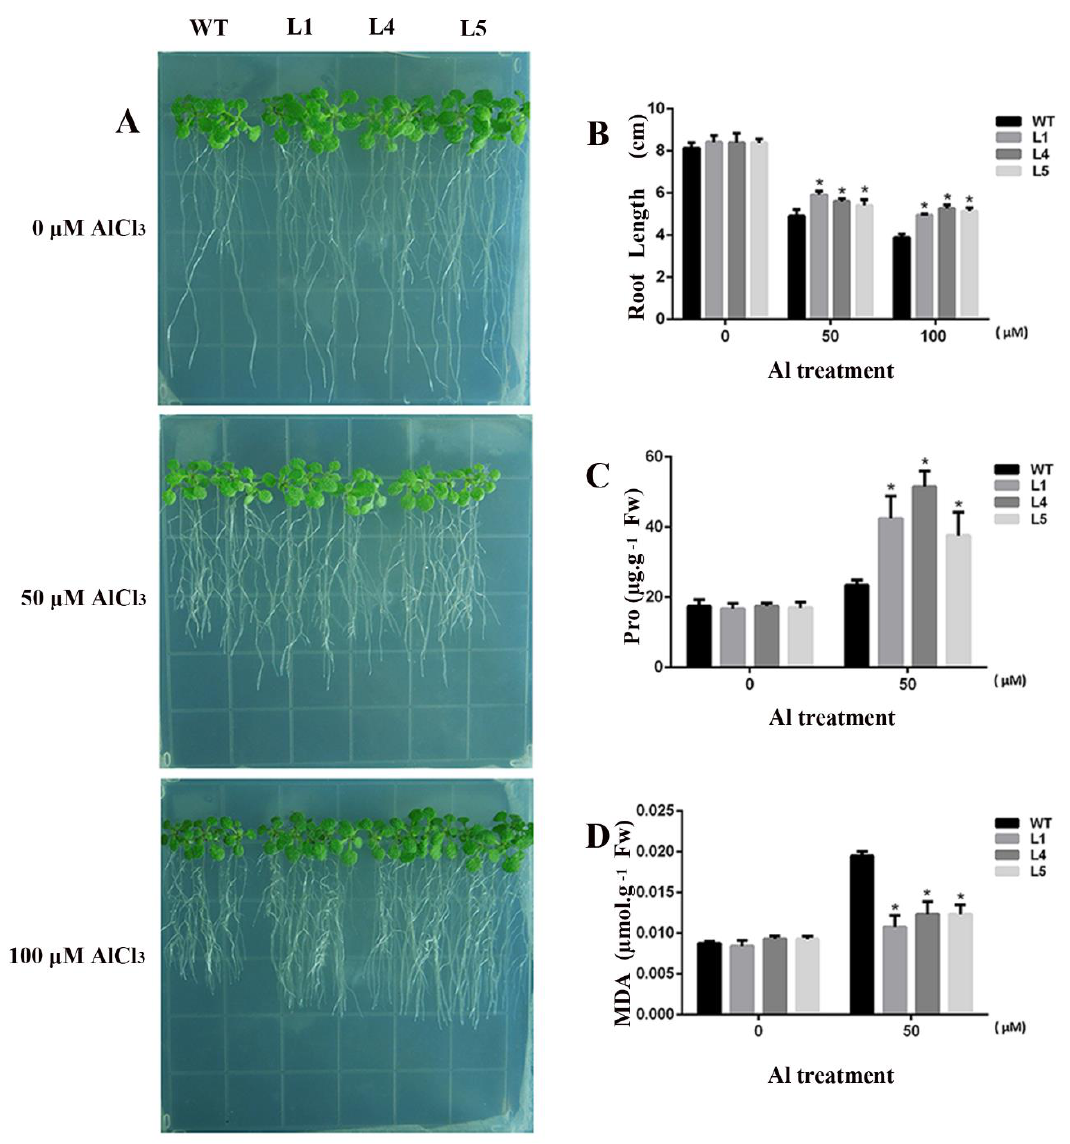
Figure 4. Overexpression of GsGIS3 in Arabidopsis enhanced Al tolerance. ( A ) The phenotypes of transgenic lines and control under AlCl 3 treatment for seven days. ( B ) Statistical analysis of root elongation. ( C ) The determination of proline content. ( D ) The determination of MDA content. The vertical columns for the average observation value of the three repetitions represent the means ± SD. Three independent biological experiments were carried out to investigate the status of seedlings and accumulations of proline and MDA in plants of WT and GsGIS3 transgenic lines under Al stress. Asterisks indicate significant differences between WT and GsGIS3 transgenic lines (* P < 0.05). WT, wild-type of Arabidopsis (Col-0); L1, L4 andL5, GsGIS3 Arabidopsis transgenic lines of T 3 generations.